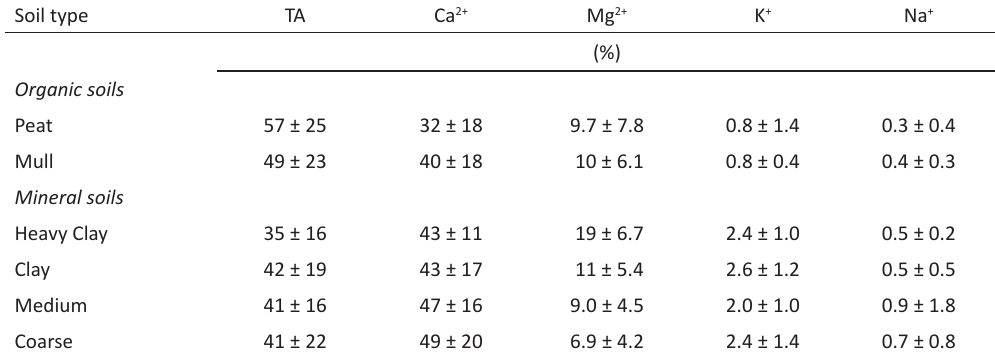
Table 6. Percentages (mean ± SD) of titratable acidity (TA; H + + Al 3+ ) and different cations (Ca 2+ , Mg 2+ , K + , Na + ) occupying the potential cation exchange capacity (CEC) sites in different soil types (see number of soil samples (n) in Table 2 and 3)